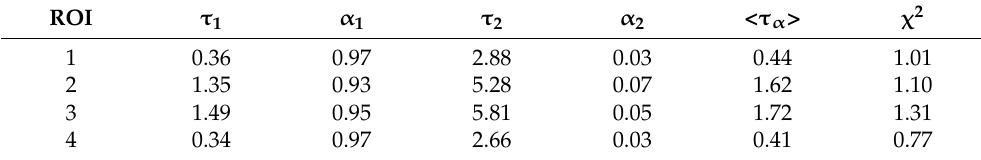
Table 1. Results of two-component fits of time-resolved data for selected ROIs of micrograph *. ROI